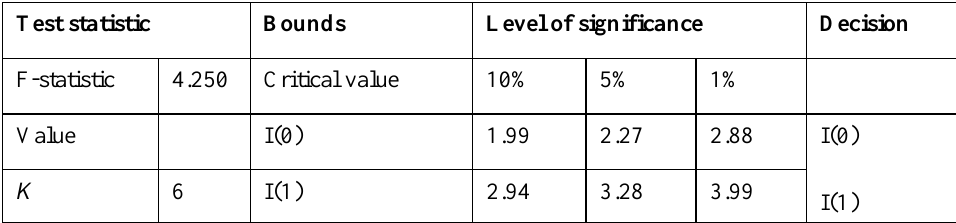
Table 4. Result of the bounds test